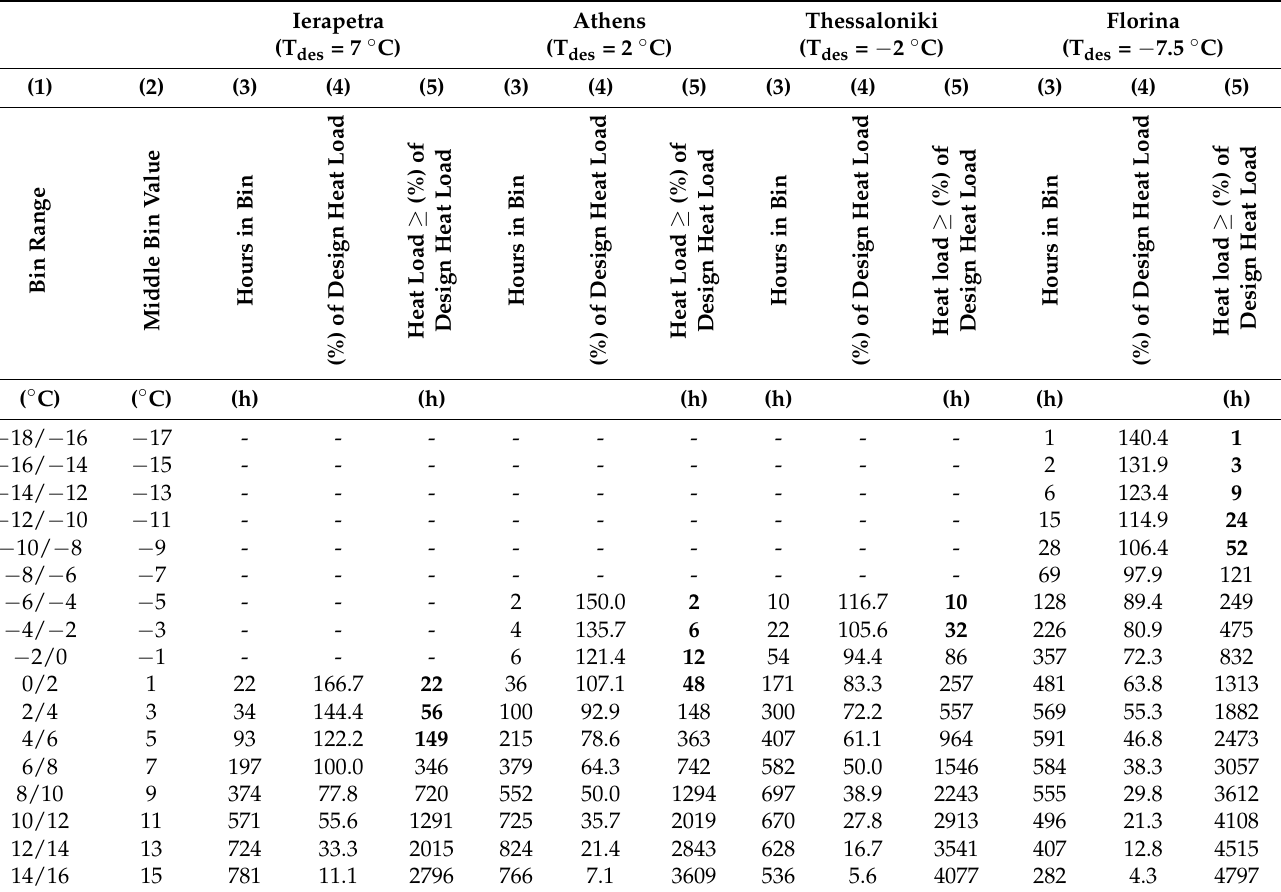
Table 1. Hours during which the space/building heat load equals or exceeds each given percentage of design heat load for the 4 representative